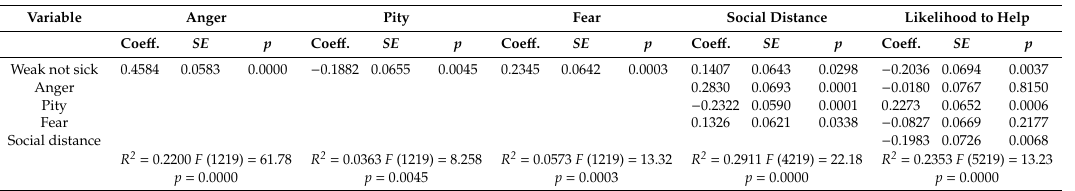
Table 3. Model coe ffi cients for the e ff ect of weak not sick on likelihood to help with anger, pity, fear and social distance as